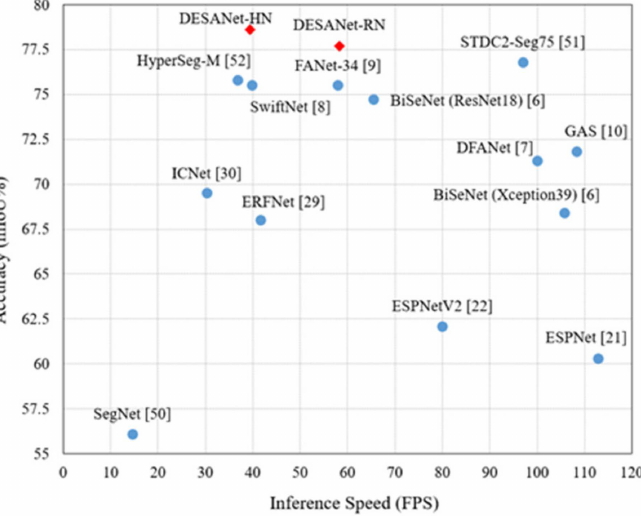
Figure 1. Speed–accuracy comparison using the Cityscapes Dataset. Our methods achieved a state-of-the-art trade-off between the accuracy and the inference